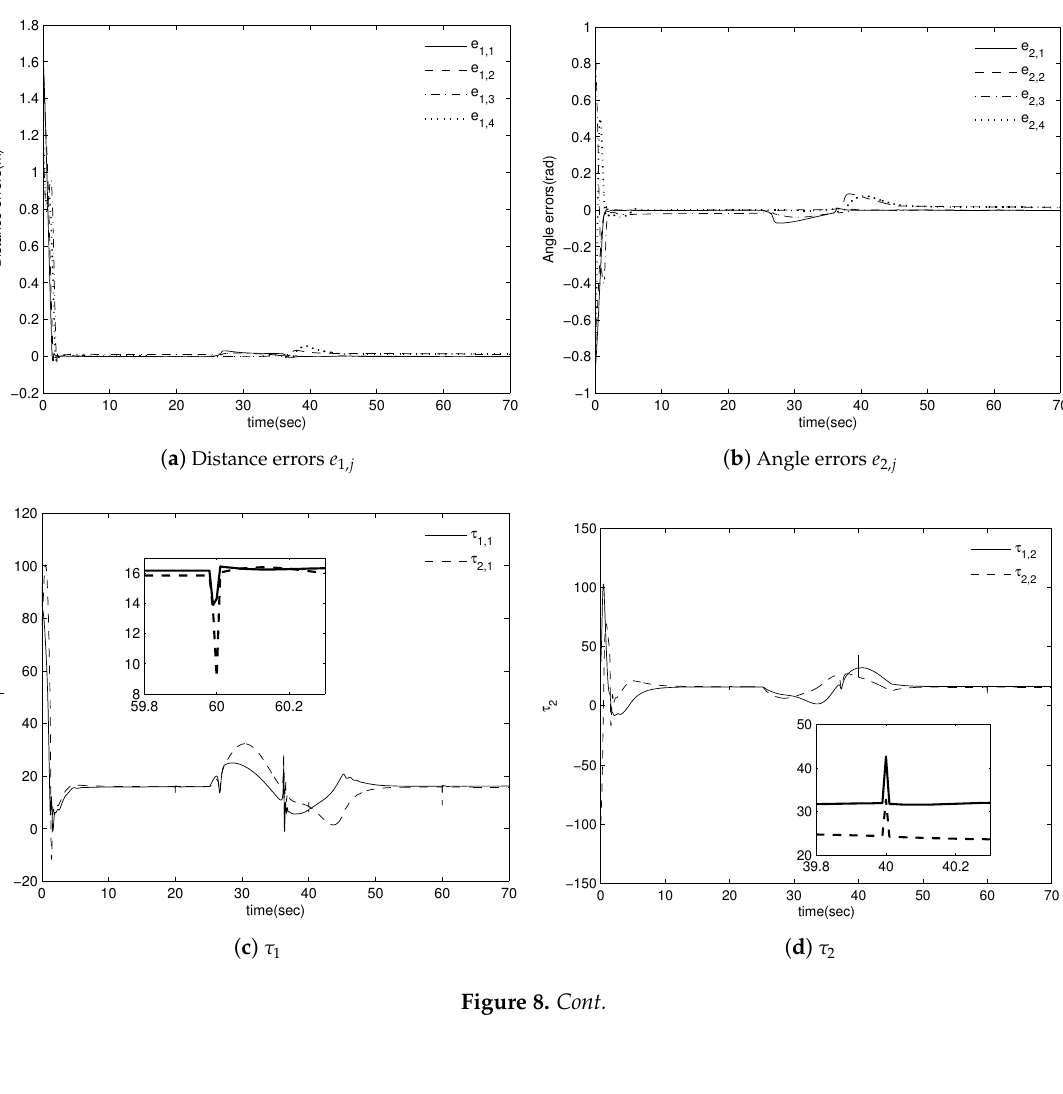
Φ ( X ) , dashed : (cid:98) W (cid:62) j j 1, j